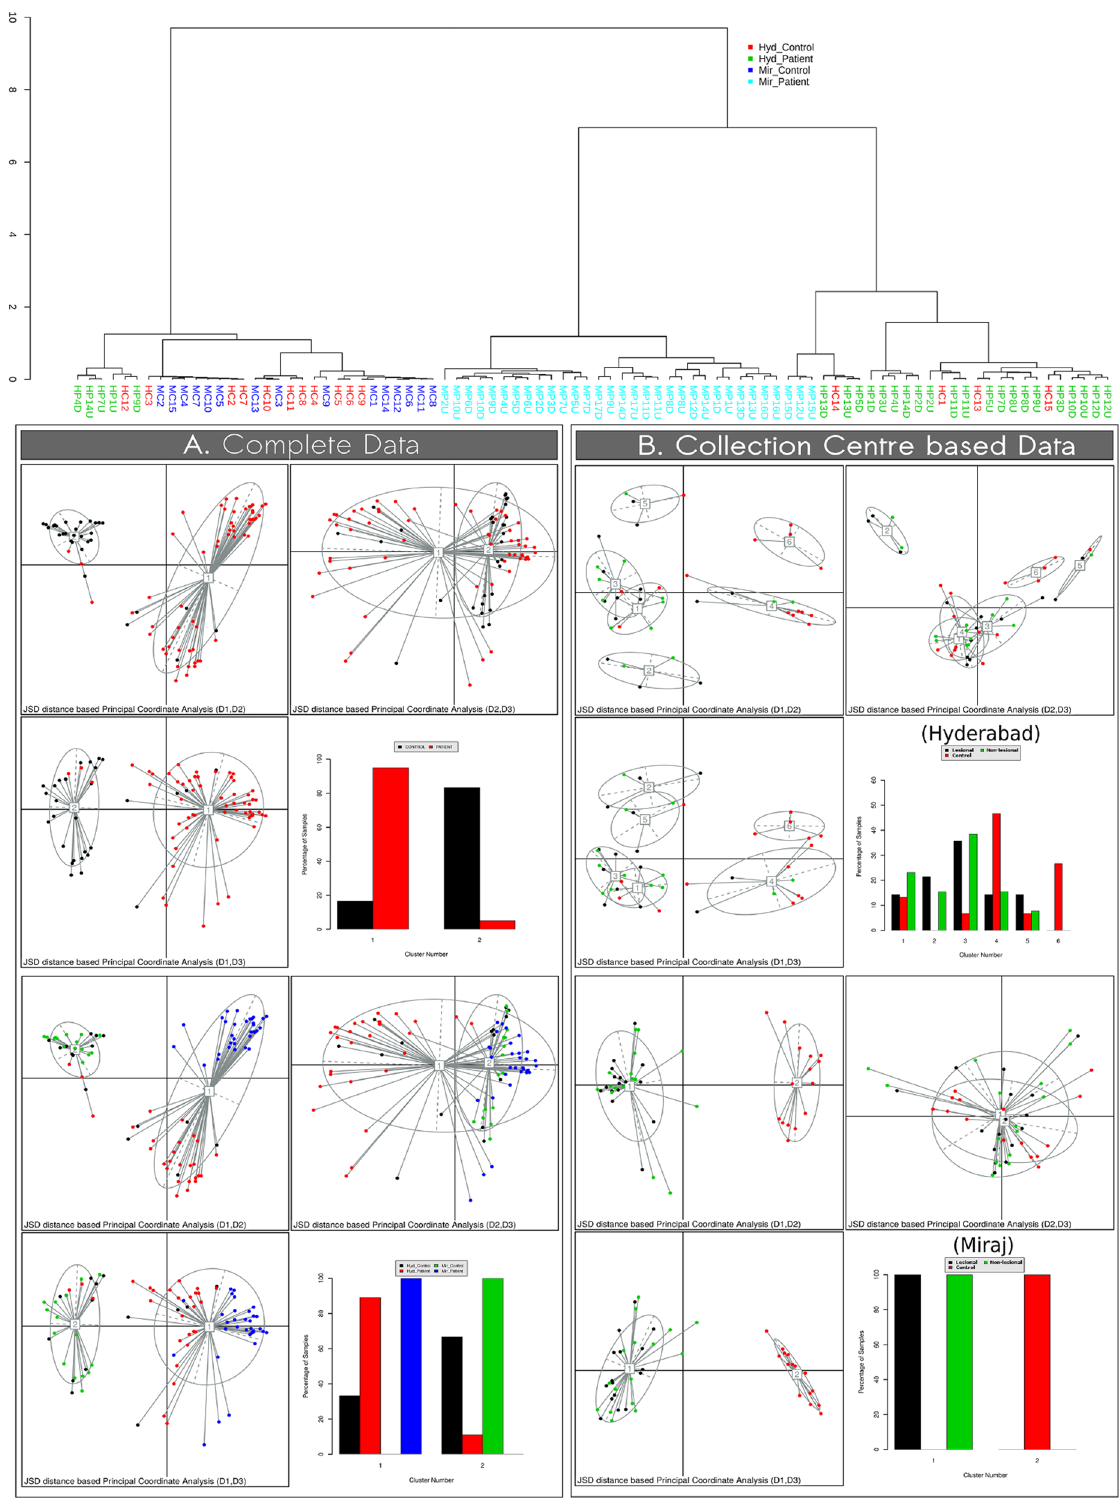
Figure 2. Principal component analysis (PCoA) of control, lesional and non-lesional bacterial communities. PCoA clustering of microbial abundance profiles (corresponding to all 88 samples) based on Jensen–Shannon (JSD) divergence metric. Results in (A) indicate formation of two clusters. Samples corresponding to controls (healthy participants) observed to group together in the same cluster irrespective of the geographical location (top portion of A ). Samples from both LS and NLS sites of LP were observed to group together in the same cluster (which is spatially separated from the cluster having the control samples (bottom portion of A ). LP samples were observed to spatially group together based on sampling location (Hyderabad or Miraj). A cladogram generated using Ward clustering is depicted in (A) . This indicates the extent of individual level similarities amongst samples from both geographic locations. Results in (B) indicate absence of unique microbiota signatures in LS and NLS sites of